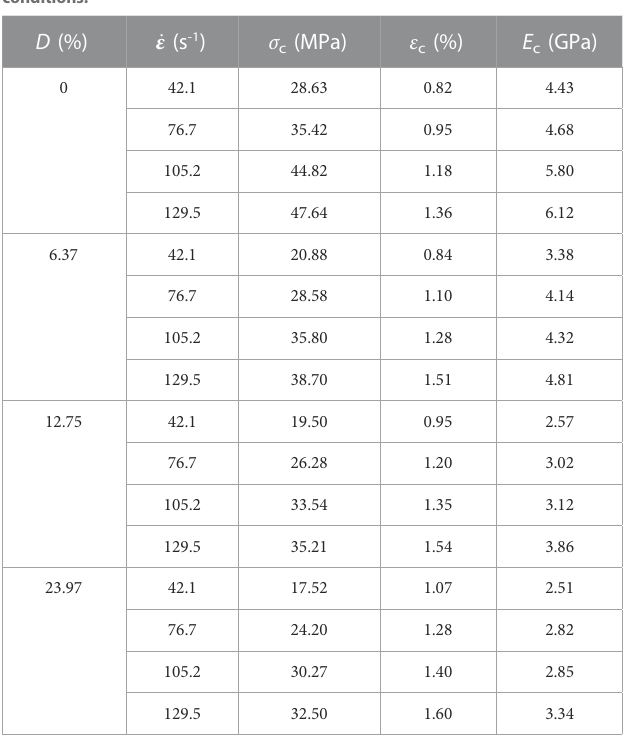
TABLE 3 Dynamic mechanical parameters of frozen sandstone under different conditions.